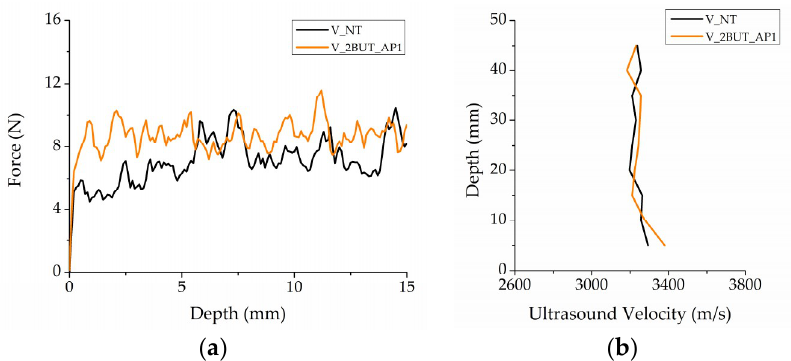
Figure 12. Vicenza stone treated with 2BU applied by brushing till saturation AP1 (V_2BU_AP1): ( a ) drilling resistance and ( b ) UPV profile. NT: Untreated stone.